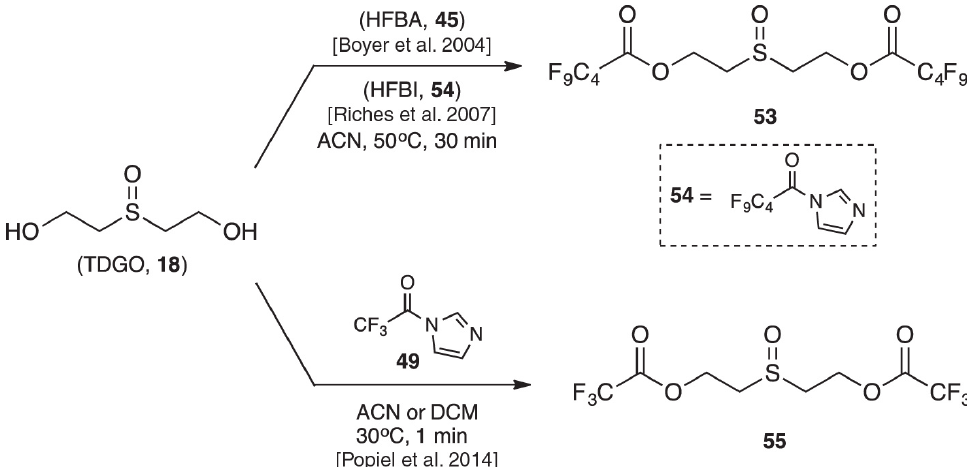
Figure 10: Derivatization of TDGO ( 18 ) with fluorine-bearing tags for its analysis by GC-MS.